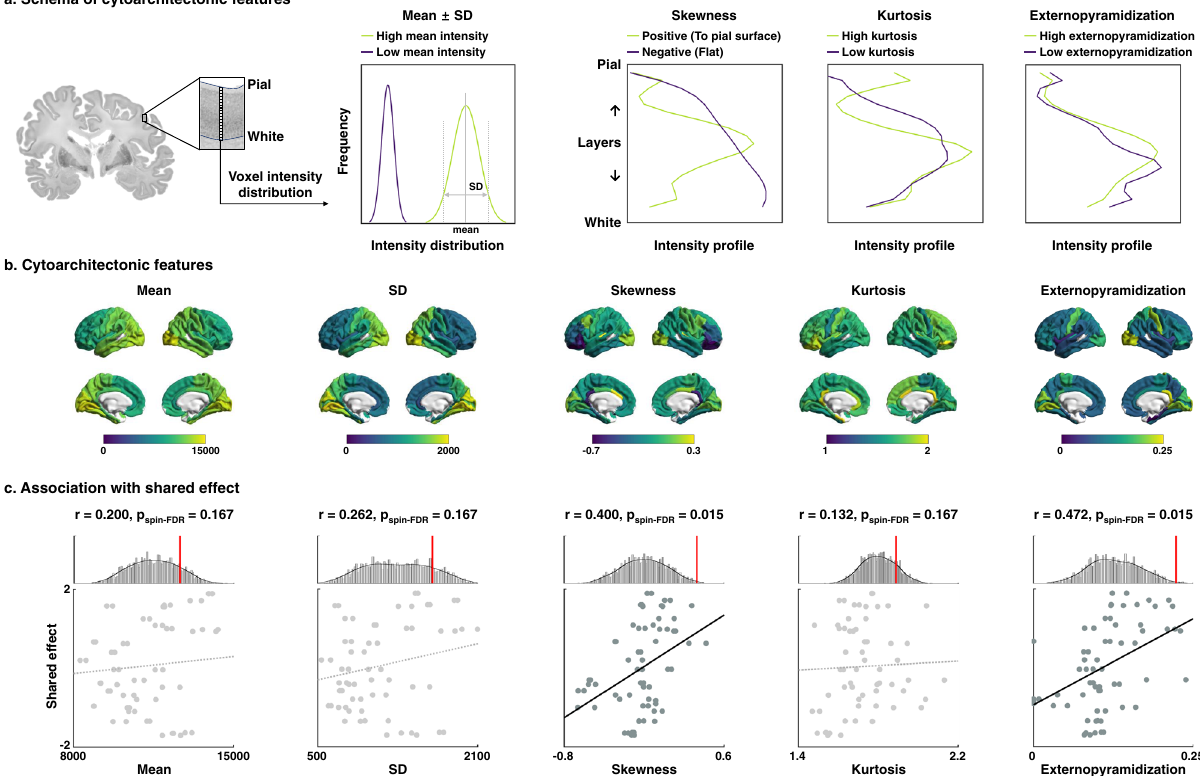
Fig. 2 Cytoarchitectonic associations with the shared disease effect. a Cytoarchitectonic moment features of mean, SD, skewness, and kurtosis, as well as externopyramidization of intracortical intensity pro fi le were calculated from the postmortem human brain, and b plotted on brain surfaces. c Spatial correlations between the features and shared effects are shown on scatter plots. The distributions of correlation coef fi cients across 1000 spin-tests are reported with histograms, and the actual r -values are represented with red bars. SD standard deviation, spin-FDR spin-test followed by false discovery